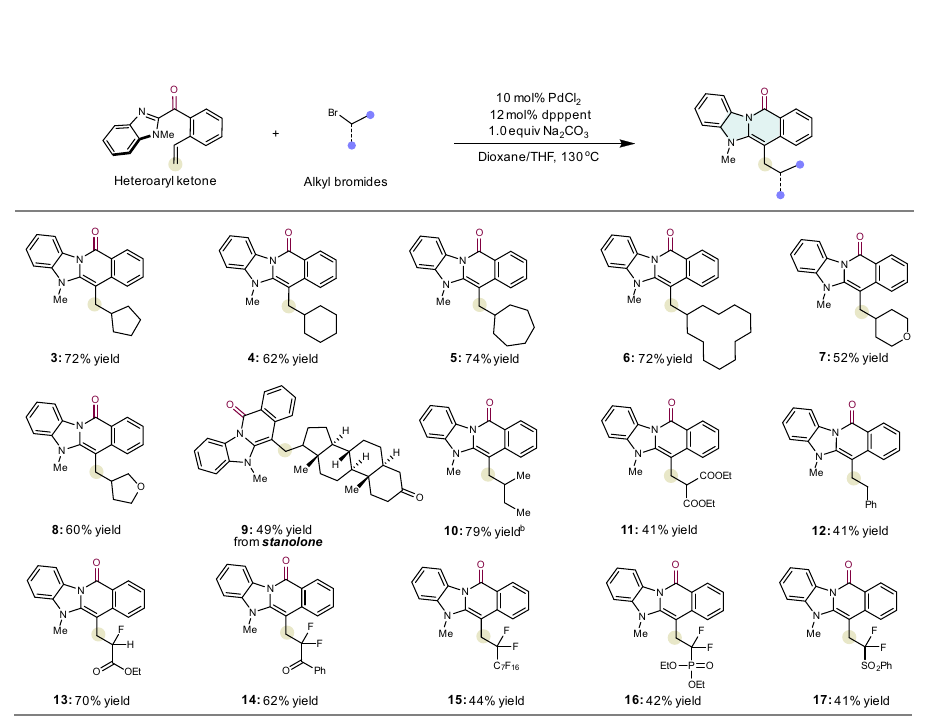
Fig. 2 Substrate scope of alkyl bromides. Unless otherwise speci fi ed, all the reactions were carried out using ketone 1 (0.1 mmol, 1.0 equiv) and alkyl bromide (0.15 mmol, 1.5 equiv.), PdCl 2 (10 mol%), dpppent (12 mol%) and Na 2 CO 3 (1.0 equiv) in dioxane/THF (1:2) at 130 °C. Isolated yields after chromatography are